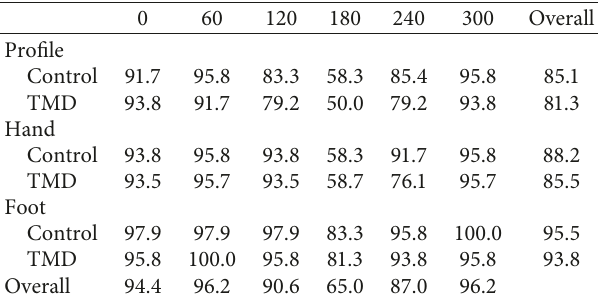
Table 3: Accuracy (%) in the two groups for each stimulus type and